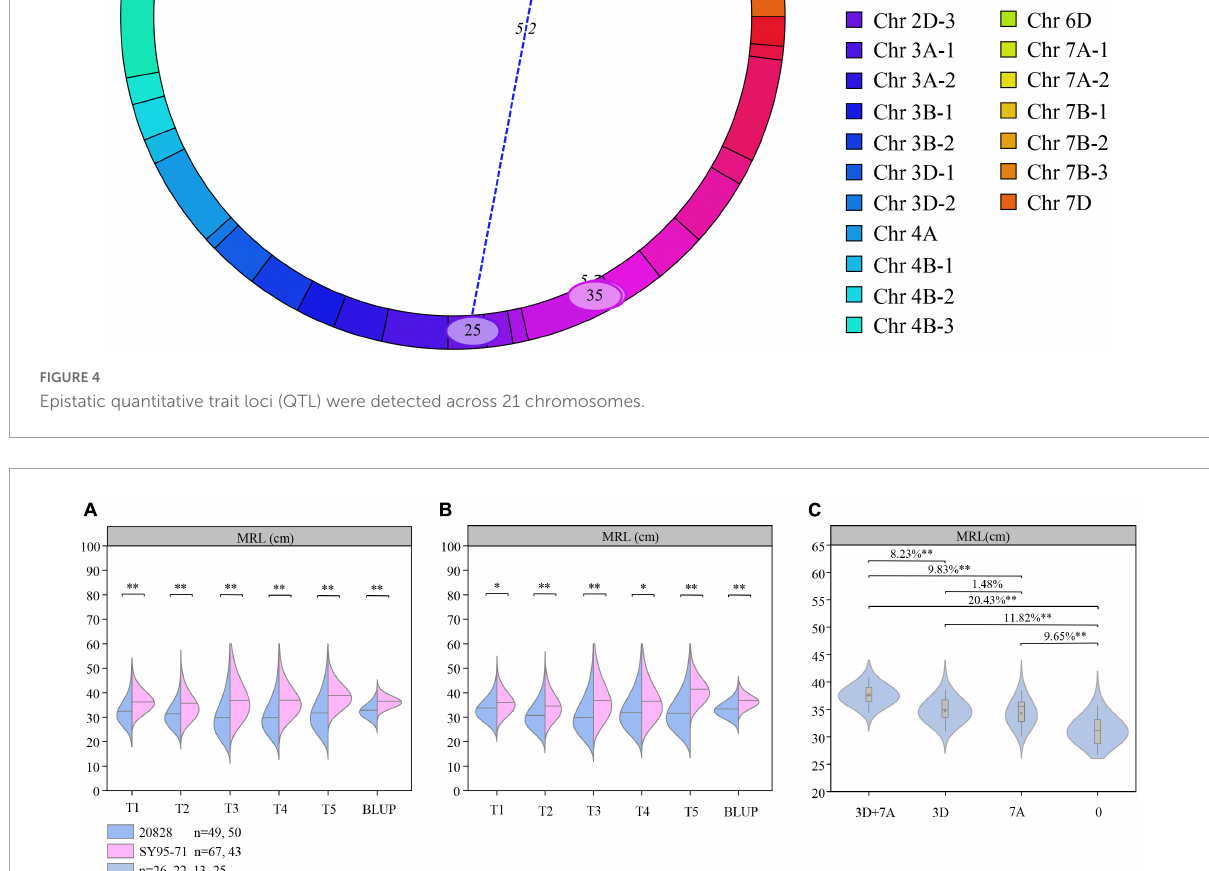
(Li et al., 2020, 2021b; Ren et al., 2022). The effect of a single gene is limited, and pyramiding effect between multiple genes is not a simple accumulation due to the complex interaction mechanism (Pakeerathan et al., 2019). We further explained the relationship between QMrl.sicau-2SY-3D.2 and QMrl.sicau-2SY-7A.2 via pyramiding analysis ( Figure 5C ). The MRL of lines with a combination of positive alleles from QMrl.sicau-2SY-3D.2 and QMrl.sicau-2SY-7A.2 was significantly